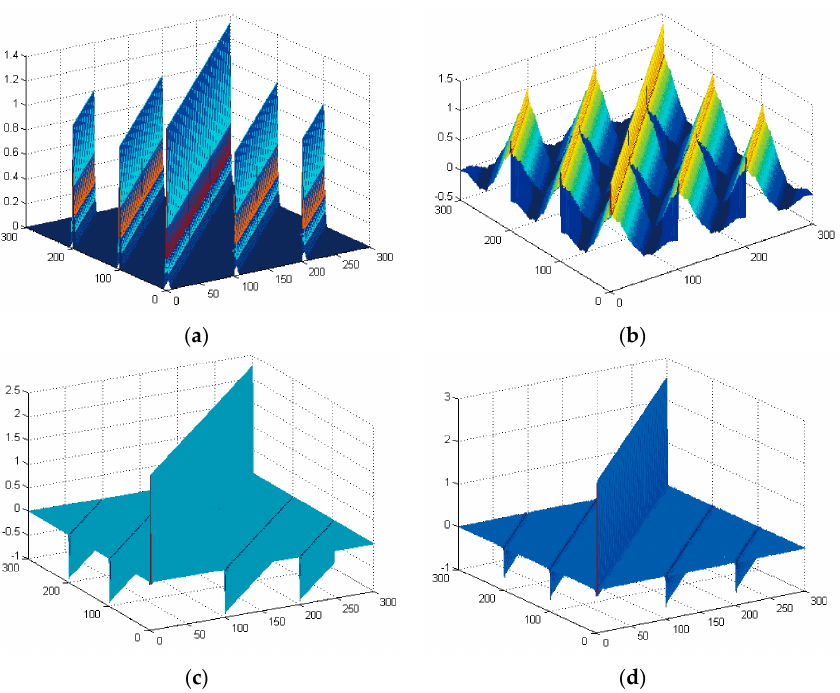
Figure 1. ( a , b ) show the covariance matrix of colored random signal and real EEG signal respectively; and ( c , d ) are their inverse covariance matrix, respectively.